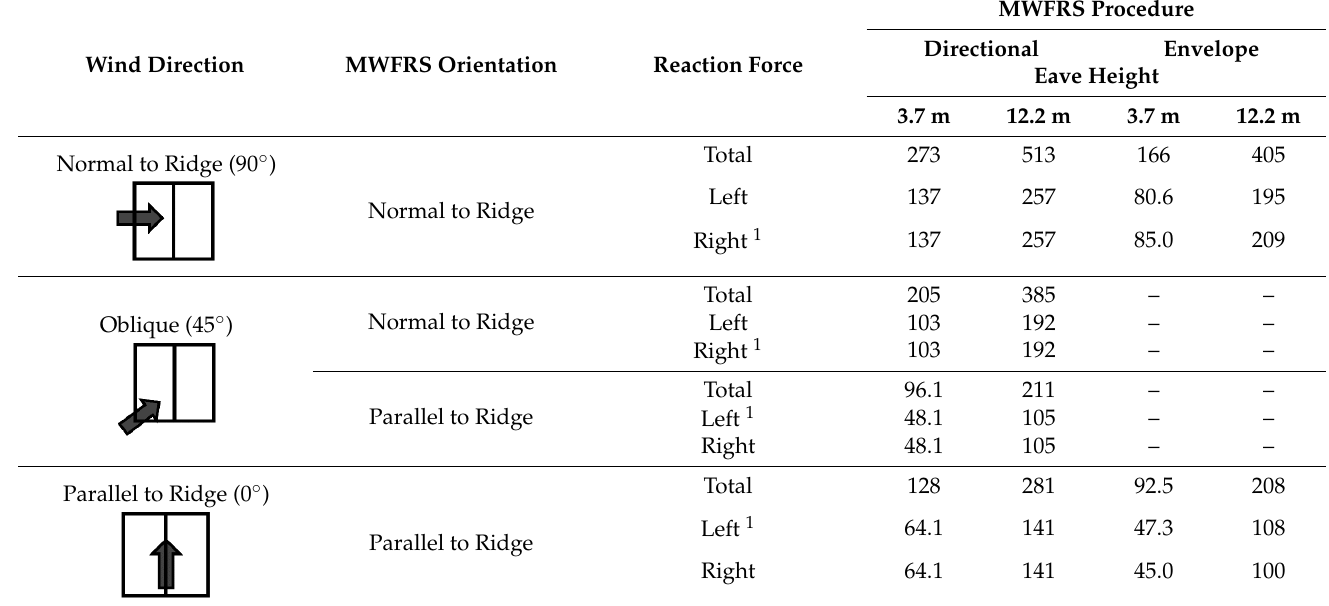
Table 2. Design base shear (kN).